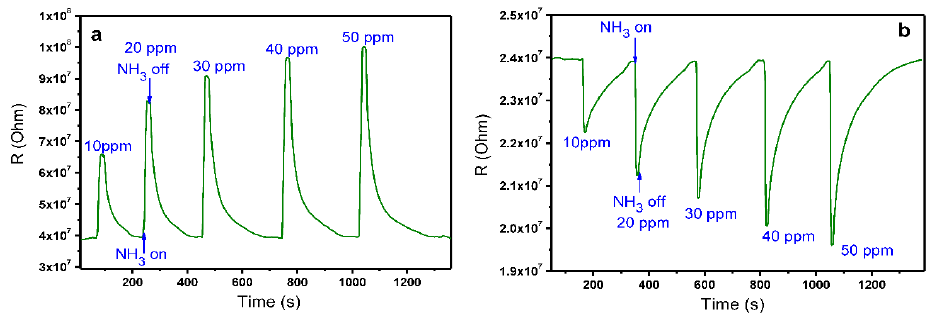
Figure 1. Sensor response of CoPcF 4 ( a ) and CoPcF 16 films ( b ) to ammonia (10–50 ppm).